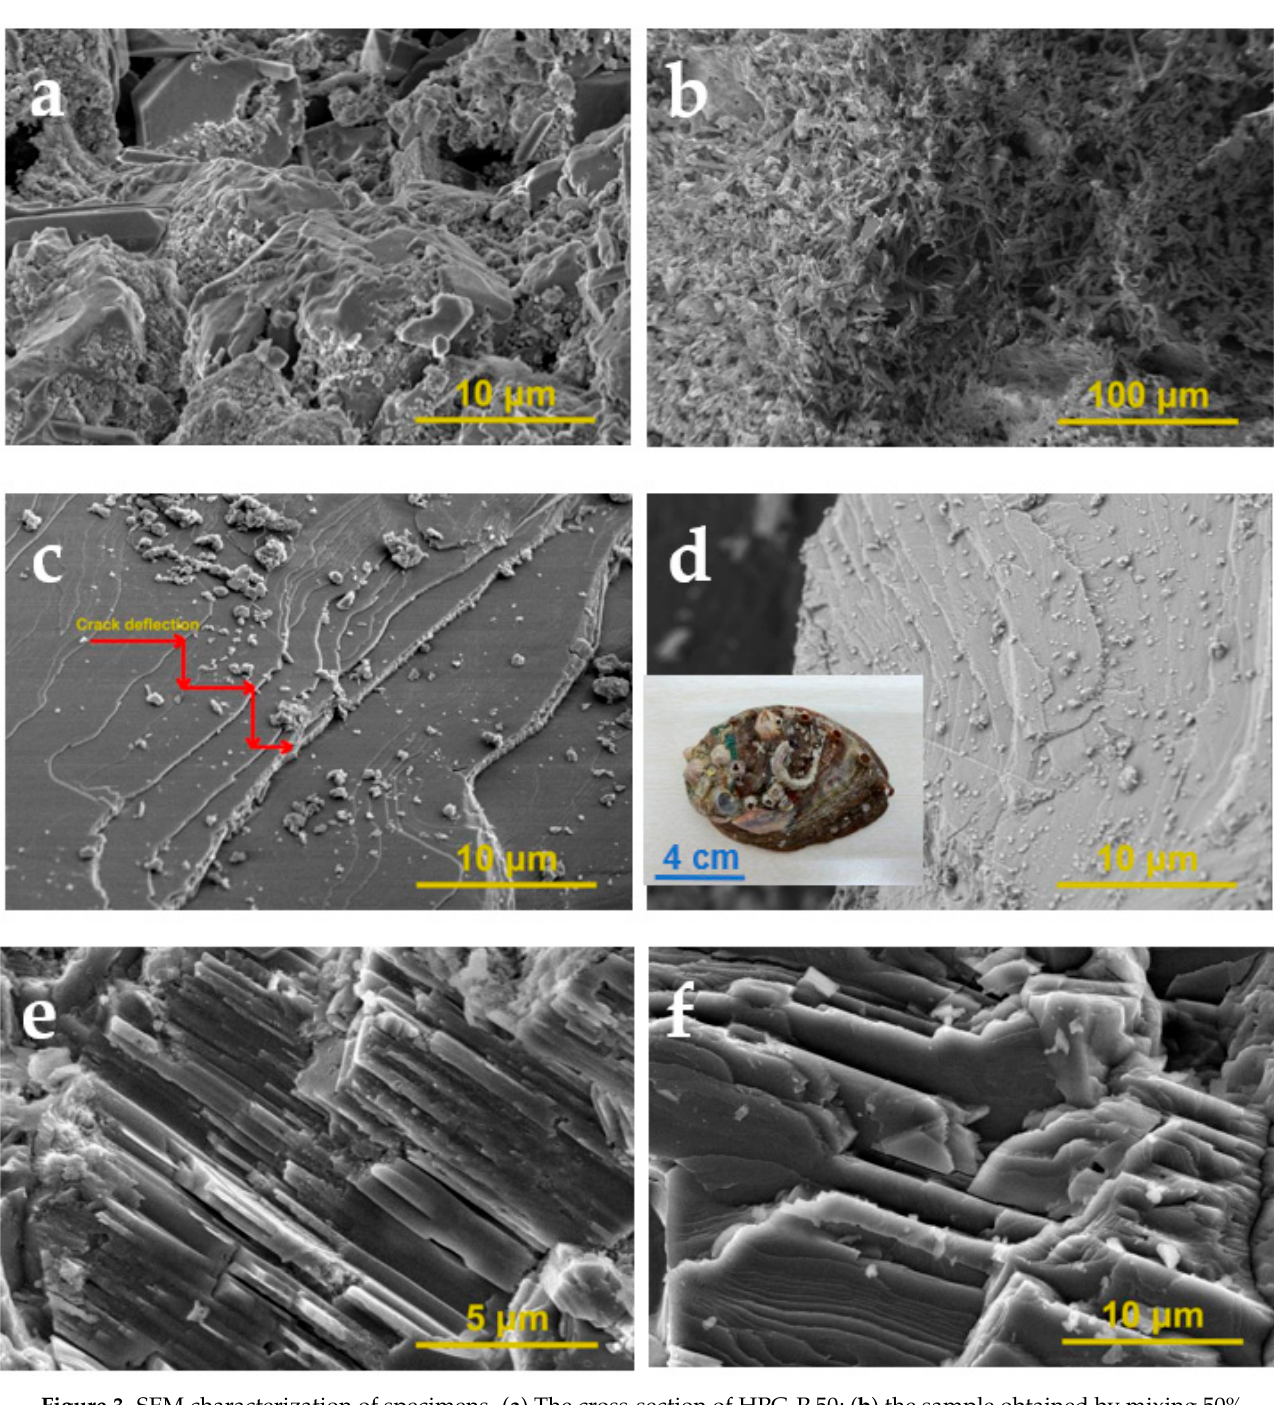
Figure 3. SEM characterization of specimens. ( a ) The cross-section of HPG-P 50; ( b ) the sample obtained by mixing 50% β -HPG and hypromellose by pouring method; ( c ) the cross-section of HPG-E 50; ( d ) the micro-structure of the Haliotis gigantea’s shell (the inset is the shell of Haliotis gigantea); ( e ) the cross-section of HPG-E 30; ( f ) The cross-section of HPG-E 70. (The cross-section of the samples was obtained by quenching in liquid nitrogen.).